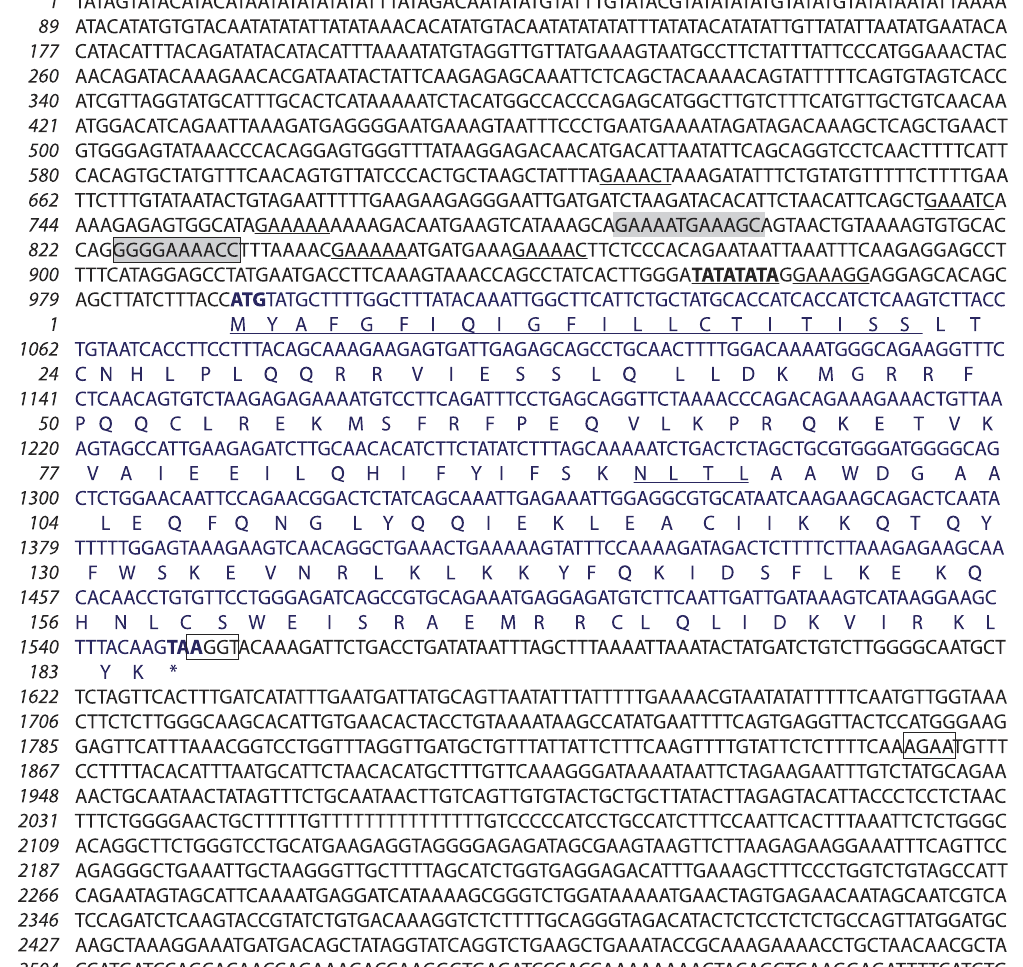
which culminate in the activation of ISGF3. Translocation of ISGF3 leads to transcriptional activation of ISGs through ISRE promoter which establishes an antiviral state 9 (Fig. 3A). To determine whether chIFN- κ medi- ates a likewise activation of signalling pathway, the chIFN- κ gene was expressed in heterologous mammalian (HEK 293) and in insect S2 cell culture system. The chIFN- κ showed a clear and dose-dependent activation of the Mx-ISRE promoter in DF-1 cells transiently transfected with plasmid containing tandem copies of an Mx ISRE element upstream to the luciferase reporter gene. Except the undiluted concentrations, the promoter acti- vation by the chIFN- κ was comparable to previously characterized chIFN- β 29 , and was markedly higher than the mock-stimulated control (Fig. 3B). To assess the potential of chIFN- κ induced activation of ISGs, similar to other IFNs, primary CEF cells were treated with the chIFN- κ and chIFN- β or were left untreated. After 12 hours of stimulation, total RNA was har- and Mx genes which are relatively well-characterized antiviral pathways in chickens 9 (Fig. 3C–E). In addition to ISGs, mRNA level of STAT1 transcription factor, which plays crucial roles in the establishment of antiviral states, was activated (Fig. 3F). Taken together, chIFN- κ activates the ISRE promoter and induces the transcriptional activation of ISGs possibly through the activation of STAT1, which is a shared-component of type I, II and III IFN signalling pathways.